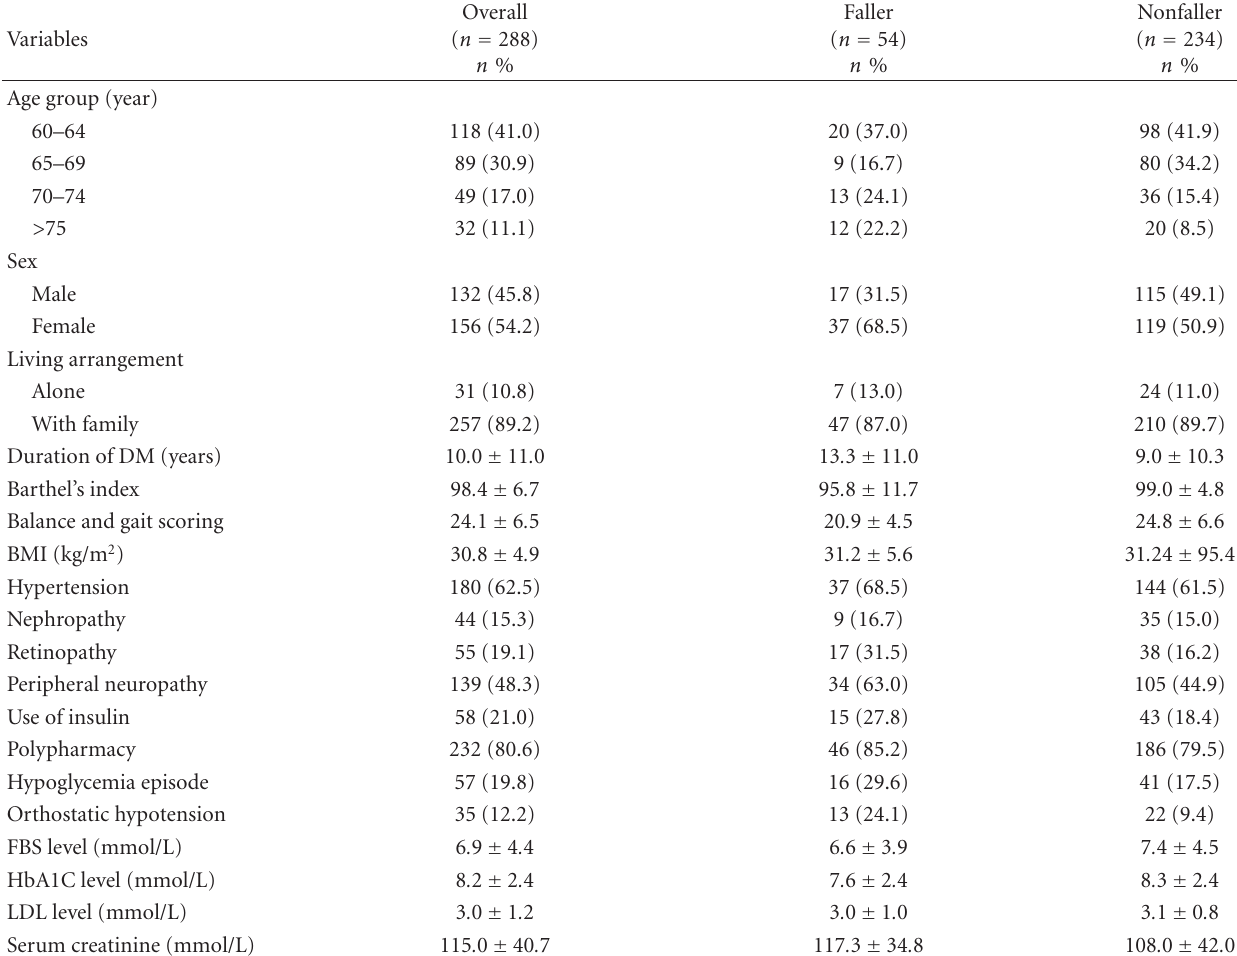
Table 1: Demographic and clinical characteristics of study